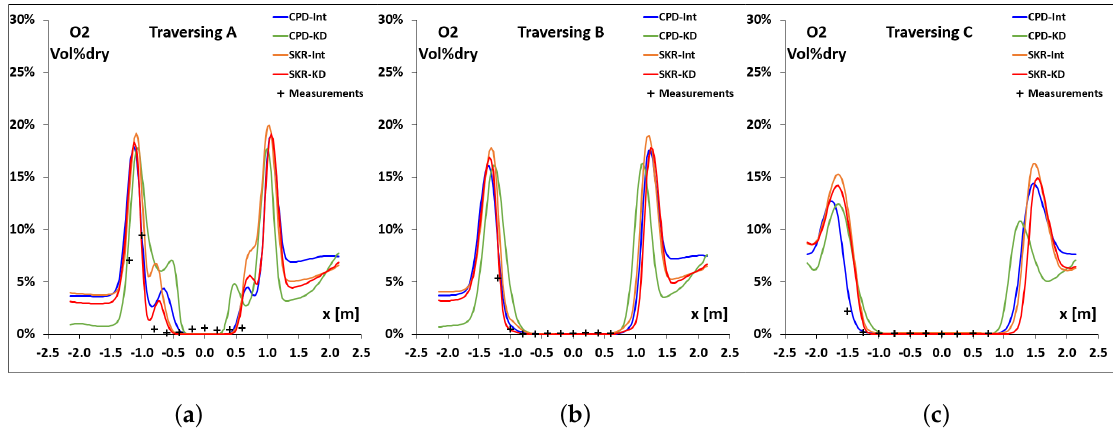
Figure 14. O 2 molar concentrations distribution along Traverses A ( a ), B ( b ) and C ( c ).